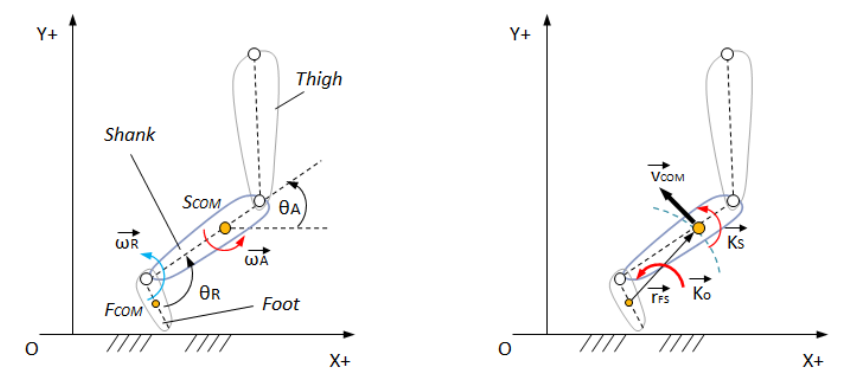
Fig. 1. Equipment setup and anatomical landmarkers of the subject.